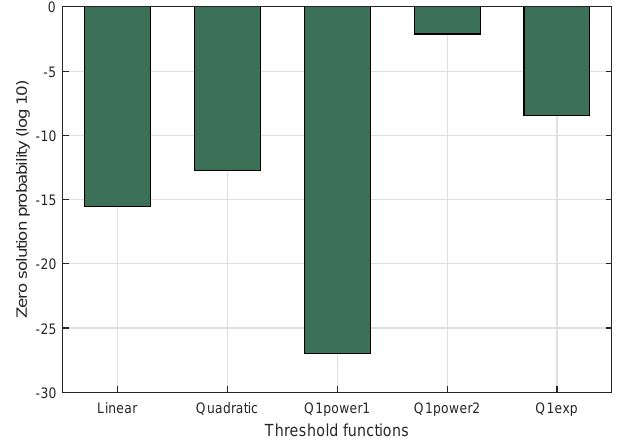
Figure 10. Zero solution probability (in log 10 ) of threshold functions in